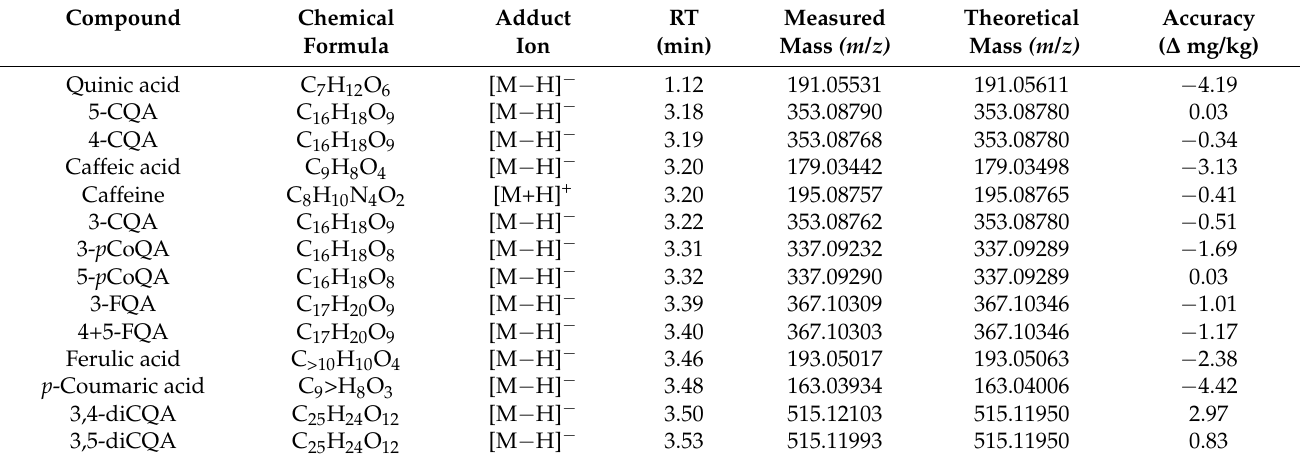
Table 1. UHPLC-MS parameters of the assayed analytes ( n =